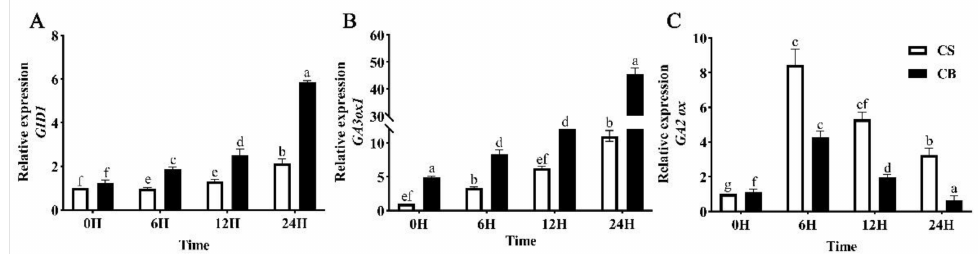
Figure 5. Effects of betaine pretreatment on the expression levels of key genes in GA signal trans- duction. The content of gibberellin in the neutrons of tomatoes under low-temperature stress was determined by qRT-PCR. ( A ) GID1, ( B ) gA3ox1, ( C ) GA2ox. Vertical bars indicate the mean calculated for three replications. CS: germination of seeds pretreated with just water under 14 ◦ C cold stress; CB: germination of seeds pretreated in 10 mmol/L of GB under 14 ◦ C cold stress. Different lowercase letters indicate significant differences at the 0.05 probability level ( p <